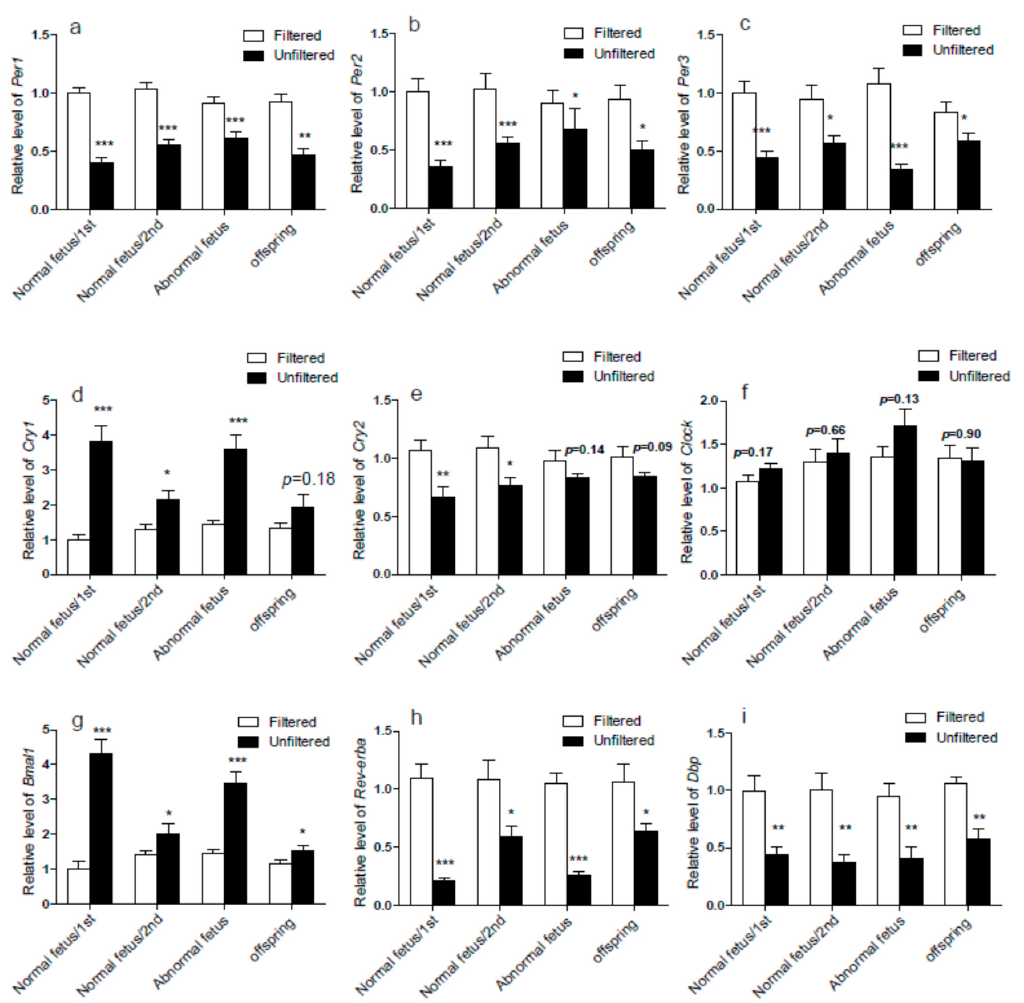
Figure 3. The circadian rhythm genes expression levels by real-time PCR. The Per1 ( a ); Per2 ( b ); Per3 ( c ); cry2 ( e ); Rev-erb α ( h ) and Dbp ( i ) expression levels decreased significantly in all groups after PM exposure. The Cry1 ( d ) and Bmal1 ( g ) expression levels were increased in all groups. The Clock ( f ) expression level did not change both in mothers and offspring. Significant difference between the two groups denoted as * p < 0.05, ** p < 0.01, *** p < 0.001, n = 6 for each group.